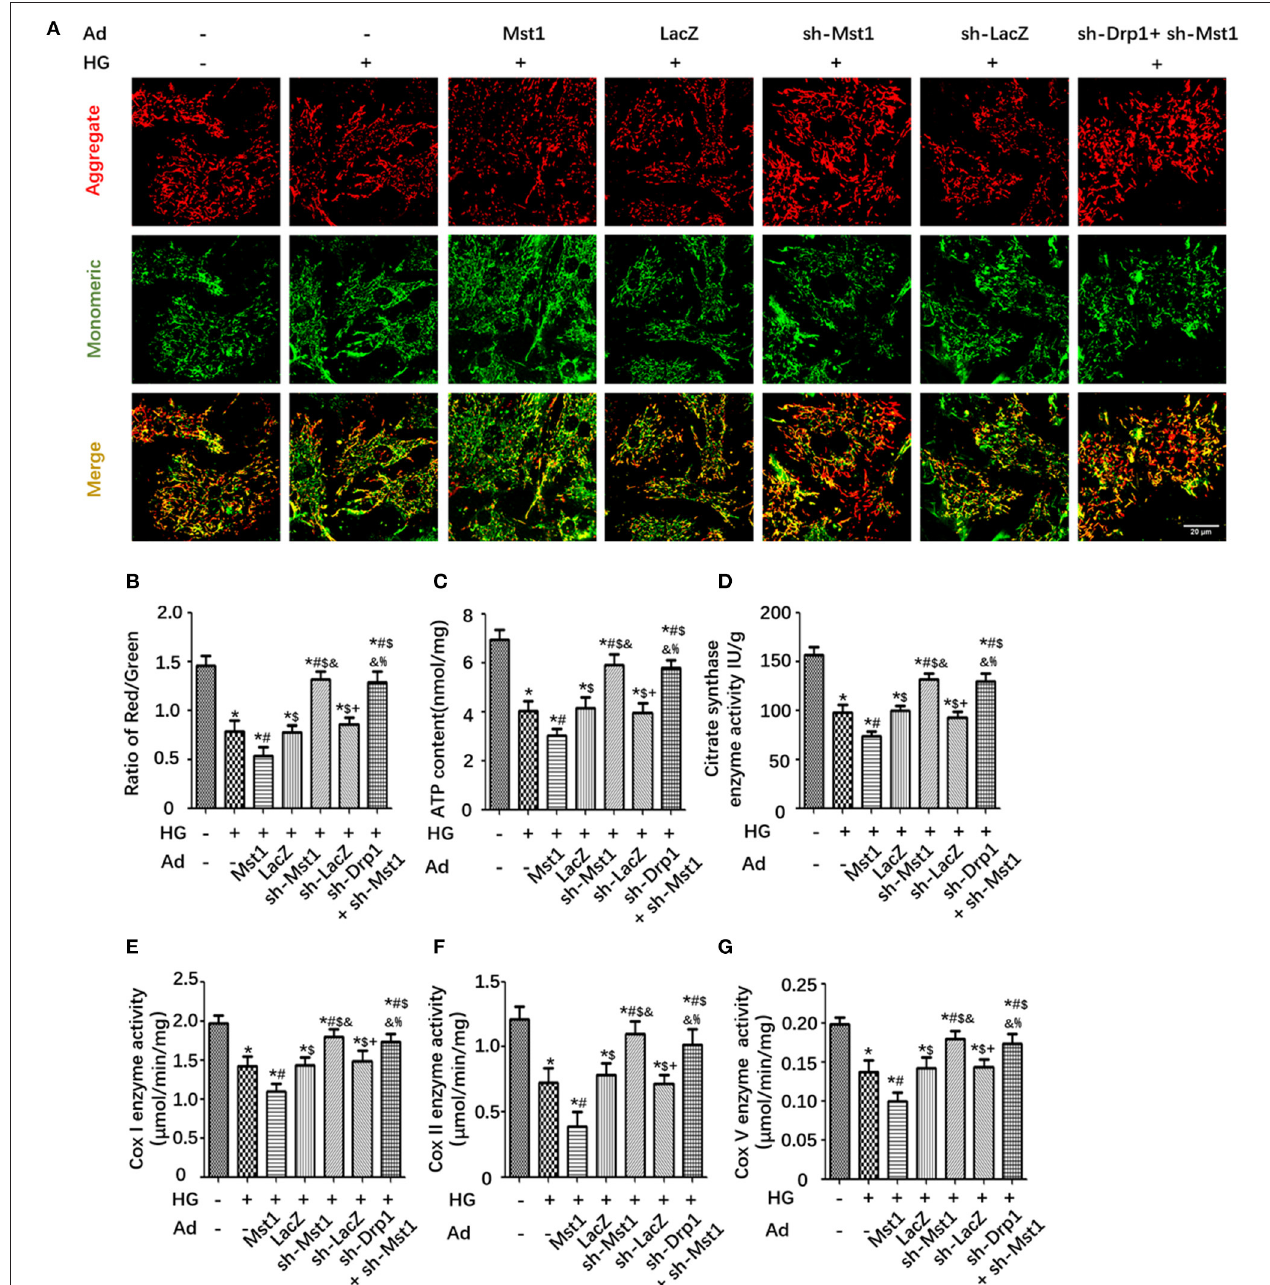
FIGURE 6 | Drp1 knockdown abolishes the effects of Mst1 on mitochondrial membrane potential and mitochondrial dysfunction. (A) Representative images of JC-1 fluorescence imaging (Scale bar: 20 µ m). (B) The ratio of aggregated (Red)/monomeric (Green) JC-1. (C) Cellular ATP content. (D) Citrate synthase (CS) activity. (E) Analysis of Complex I activity (ELISA assay) in primary cardiomyocytes. (F) Analysis of Complex II activity (ELISA assay) in primary cardiomyocytes. (G) Analysis of Complex V activity (ELISA assay) in primary cardiomyocytes. The columns and error bars represent the means and SEM. * P < 0.05 vs. Con; # P < 0.05 vs. HG; $ P < 0.05 vs. HG + Ad- Mst1; and P < 0.05 vs. HG + Ad-LacZ; + P < 0.05 vs. HG + Ad-sh- Mst1; and % P < 0.05 vs. HG + Ad-sh-